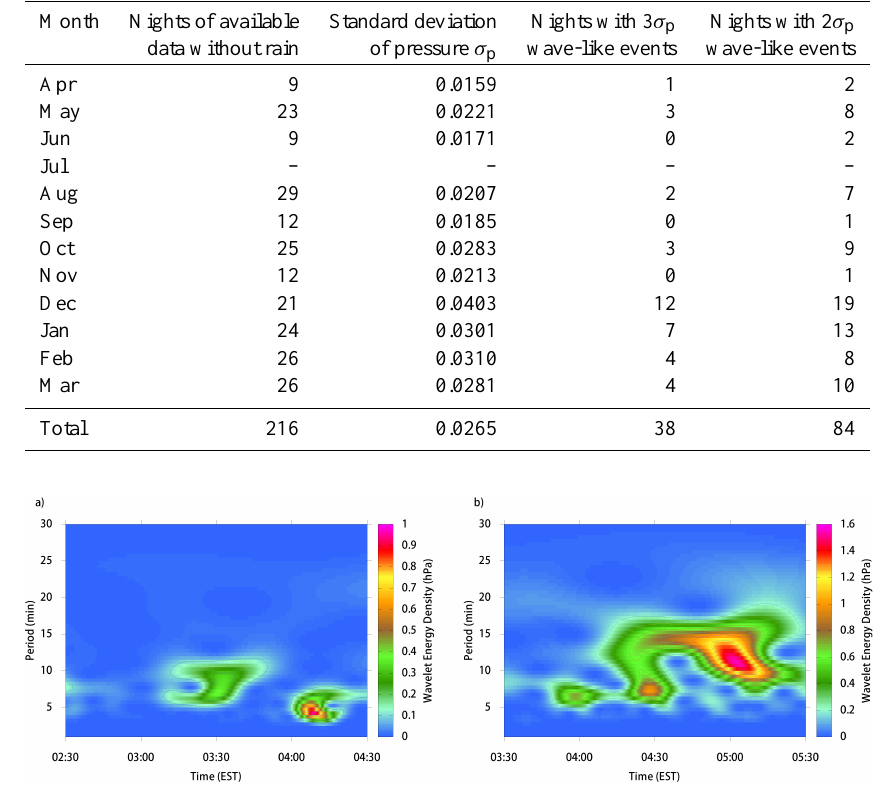
Fig. 1. Wavelet analysis of surface static pressure data from the microbarograph sensor for (a) 23 April 2009 and (b) 3 December 2009.